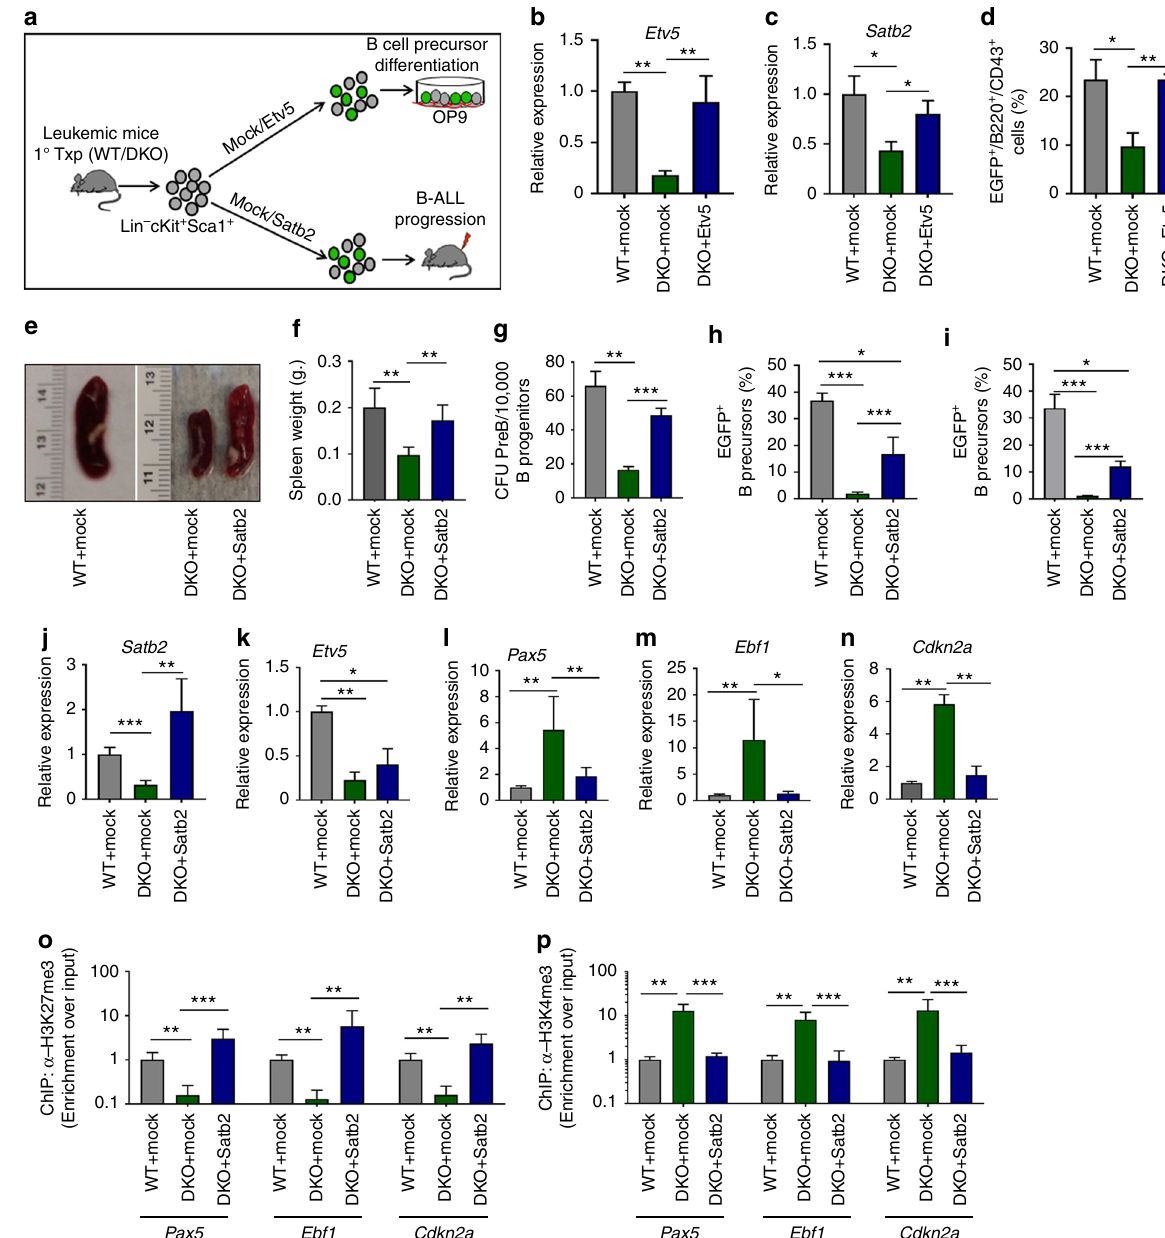
aPKC de fi cient B-cell progenitors (Supplementary Figure 10D). (Supplementary Figures 10F – G), and downregulation of Myc (Supplementary Figures 10H – I), indicating that these activities are Satb2 independent. Altogether, these data indicate that Satb2 Figure 10E), nuclear translocation of Numb is downstream of aPKC and Etv5, and that ectopic expression of